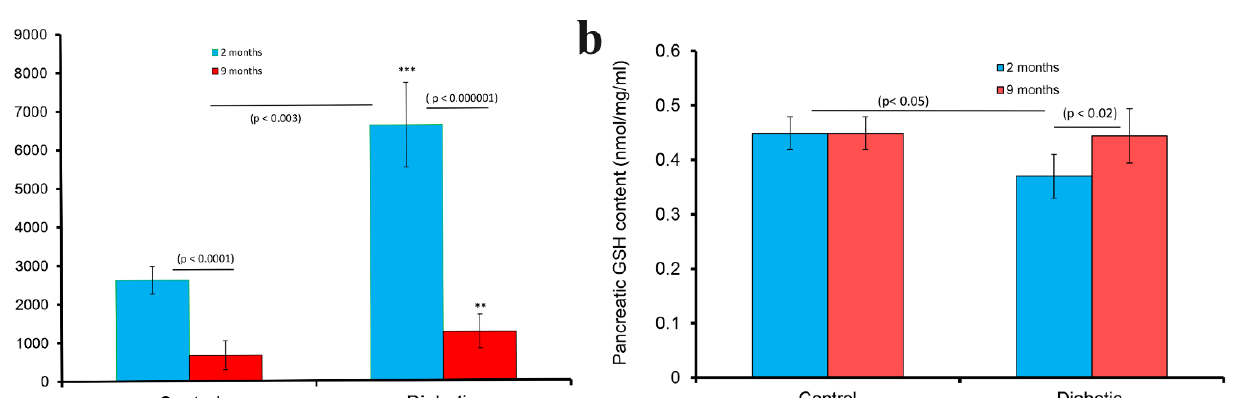
Figure 9. Histogram showing thiobarbituric acid reactive substances (TBARS) in the pancreas tissue fragments of diabetic rats 2 (blue) and 9 months (red) after the onset of diabetes. TBARS was also determined in age-matched controls. TBARS was significantly ( p < 0.002) higher in the pancreas of rats with 2-month-old diabetes compared to that of 9-month-old rats. The level of TBARS was significantly ( p < 0.009) higher in the pancreas of younger (2-month-old) rats compared to aged (9-month-old) in non-diabetic conditions ( a ). Histogram showing rate of TBARS in the pancreas of diabetic rats 2 (blue) and 9 months (red) after the onset of diabetes is shown in ( b ). Rate of TBARS was also determined in age-matched controls. The rate of TBARS was significantly ( p < 0.03) higher after the onset of diabetes in the older age group. The rate of TBARS was significantly ( p < 0.02) higher in the pancreas of rat with 9-month-old of diabetes, compared to those with a shorter period of diabetes ( b ).